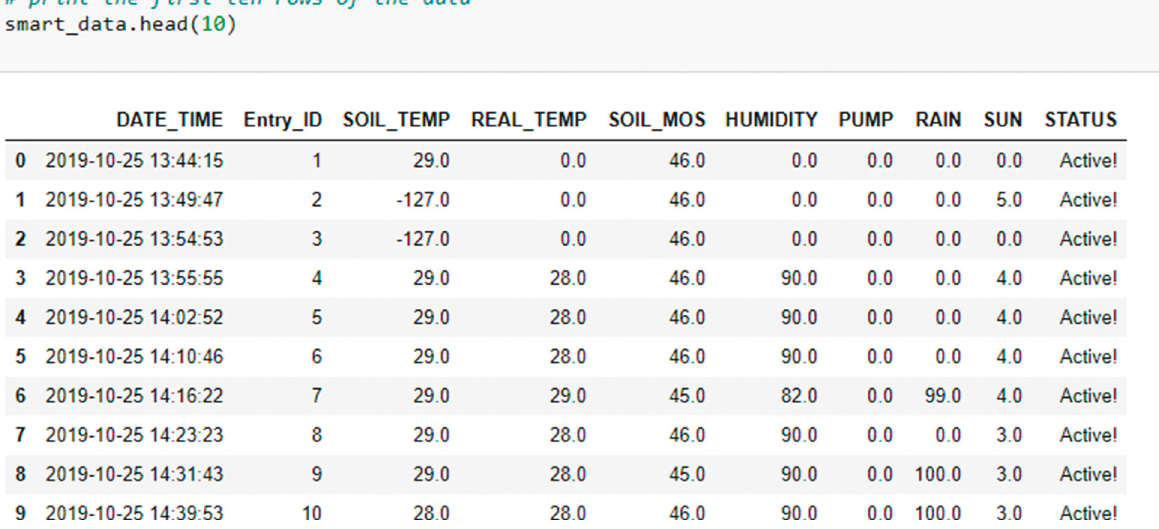
Figure 8: The first 10 rows of the dataset.